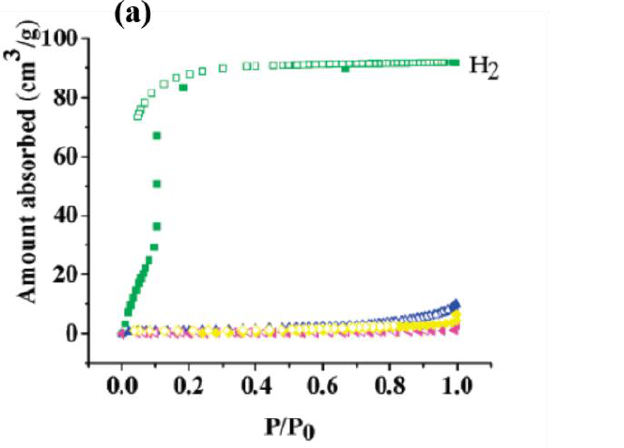
(COO) as the metal node, and 4,4′-Bpe as the organic linker. 2 4 and ( b ) CO . Reprinted with 2 2